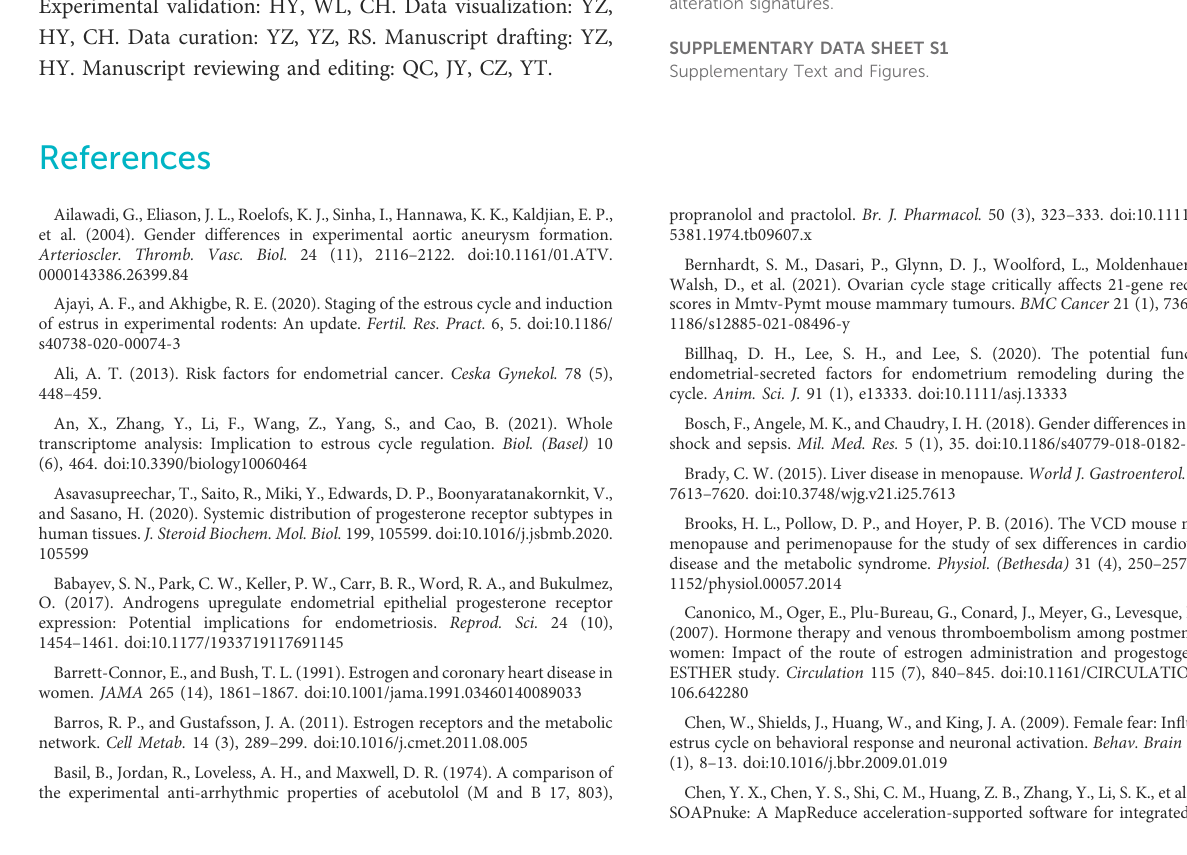
SUPPLEMENTARY TABLE S2 Supplementary Data S2. Details of manually curated transcriptomic alteration signatures. SUPPLEMENTARY DATA SHEET S1 Supplementary Text and